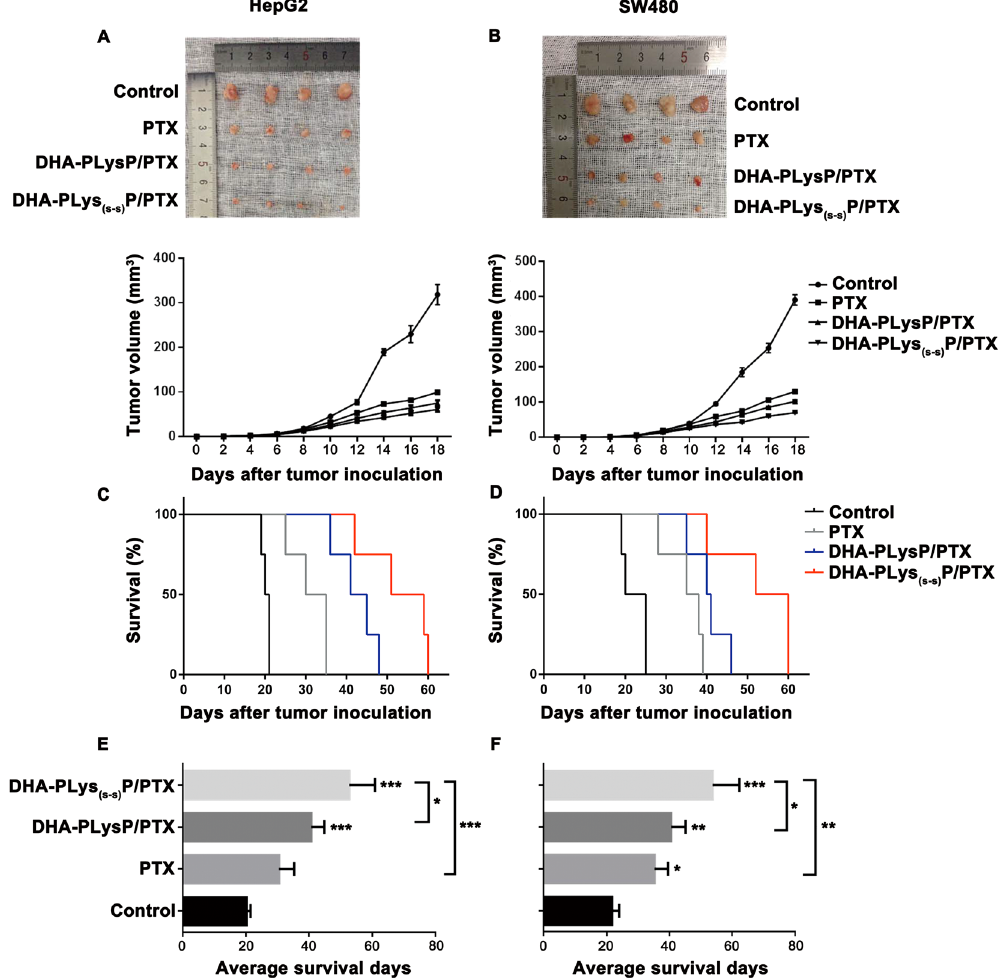
Figure 5. Effects of free PTX, DHA-PLysP/PTX and DHA-PLys (s-s) P/PTX micelles on HepG2- and SW480- bearing nude mice. Thirty-two female nude mice were implanted s.c . with 1 × 10 6 HepG2 or SW480 cells. Approximately 5 days after the implantation, these tumor-bearing nude mice were i.v . treated with different PTX formulations every three days for total five times. ( A,B ) On day 18, 16 tumors from different treatment groups were excised (n = 4). The tumor sizes were measured with a digital caliper every two days. ( C,D ) Mice survival was monitored regularly. Log-rank test (n = 4). ( E,F ) The average tumor volumes were analyzed (n = 4). * p < 0.05, ** p < 0.01, *** p <